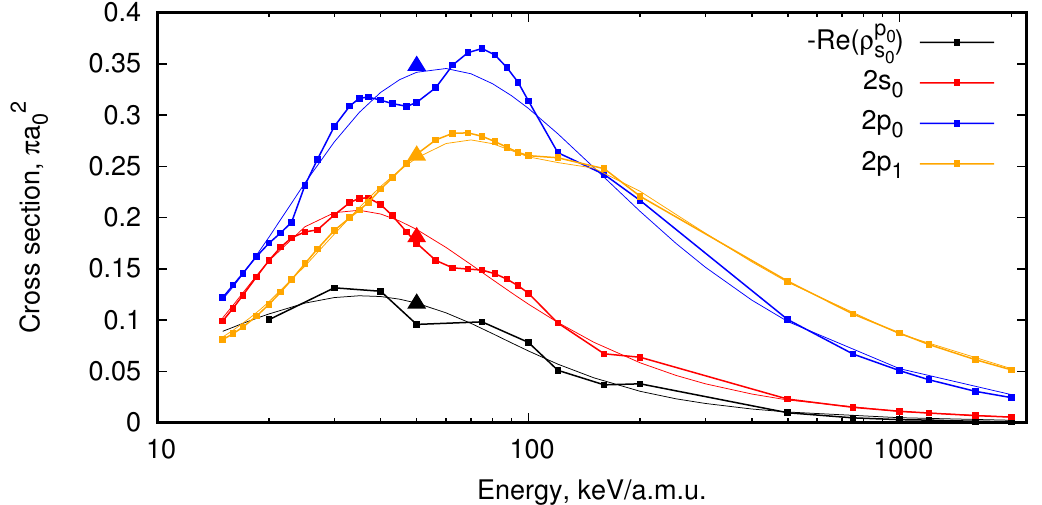
Figure 2. Excitation cross sections for n = 2 states and real part of the coherence term [22] (thick lines with squares). The results of the fit are shown as thin lines using the same colours. The new convergent close coupling (CCC) data at 50 keV are shown as triangles using the same colours (Table 1 of Reference [23]).